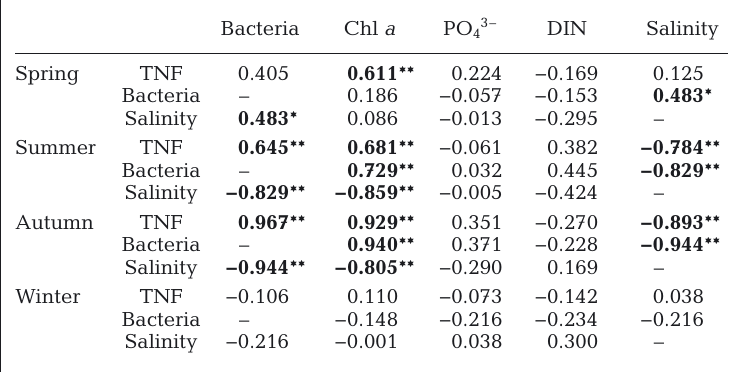
3. Correlations between total nanoflagellate (TNF) abundance, bacterial abundance and salinity and other factors in Sungo Bay in the 4 seasons.